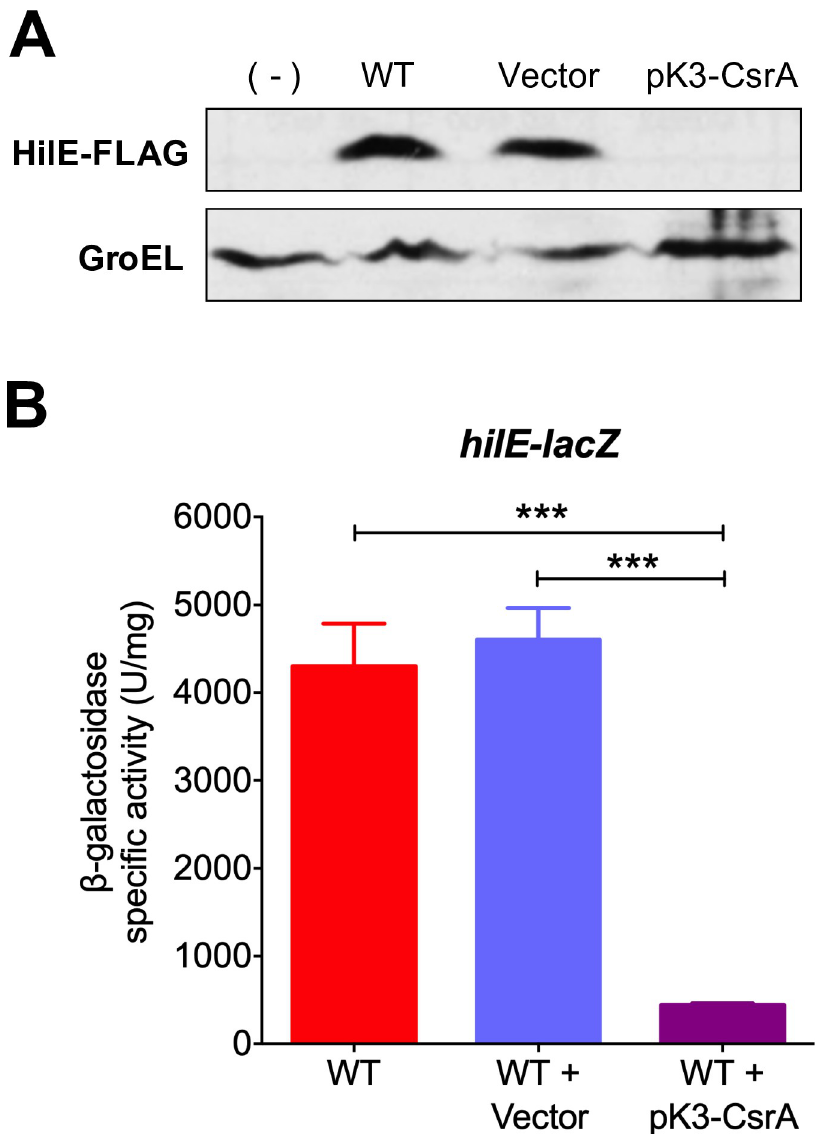
Fig 1. CsrA represses expression of hilE . (A) HilE-FLAG levels in the WT S . Typhimurium strain carrying a chromosomal FLAG-tagged hilE gene in the absence or presence of pMPM-K3 vector or the pK3-CsrA plasmid, which expresses CsrA from a constitutive promoter, were analyzed by Western blotting using monoclonal anti-FLAG antibodies. As a control for protein loading, the expression of GroEL was also determined using polyclonal anti-GroEL antibodies. A WT S . Typhimurium strain without the FLAG-tagged hilE gene was used as negative control (-). (B) β - galactosidase activity of the translational hilE-lacZ fusion contained in the philE-lacZ plasmid was determined in the WT S . Typhimurium strain in the absence or presence of pMPM-K3 vector or the pK3-CsrA plasmid. Data represent the average of three independent experiments done in duplicate. Error bars denote the standard deviations. Statistically different values are indicated ( ��� , p -value < 0.0001). Western blot and β -galactosidase assays were performed with samples taken from bacterial cultures grown in LB at